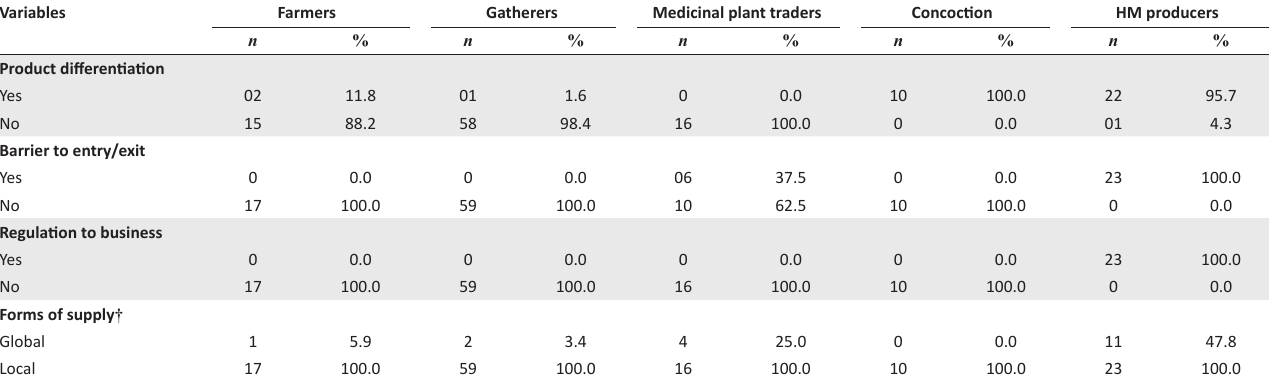
TABLE 5: Other elements of the chain structure. Variables Farmers Gatherers Medicinal plant